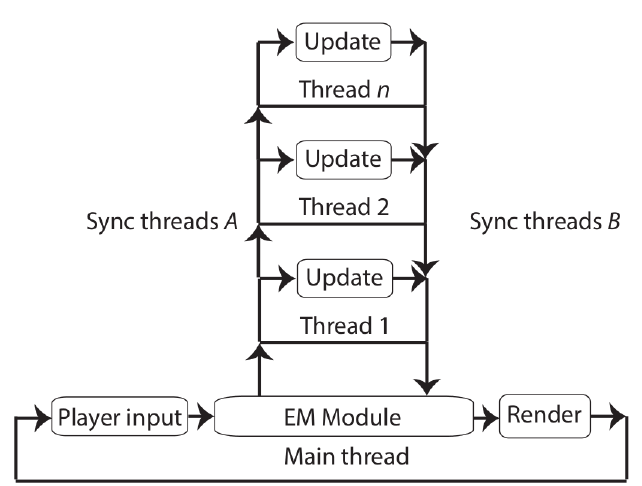
Figure 10. Parallel game loop model with multiple